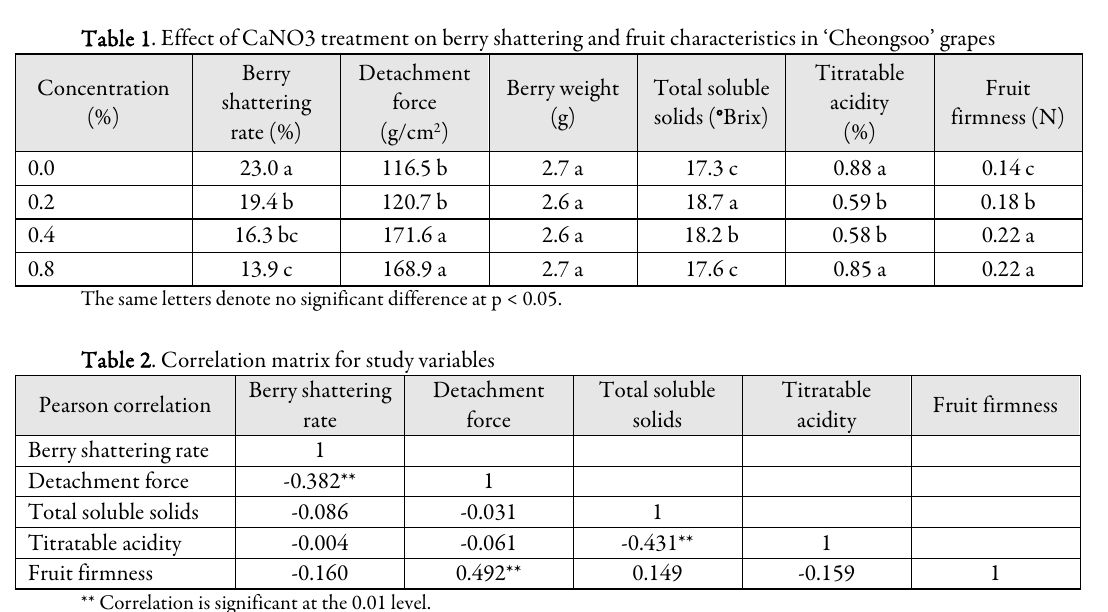
Titratable Fruit acidity firmness (N) (%)